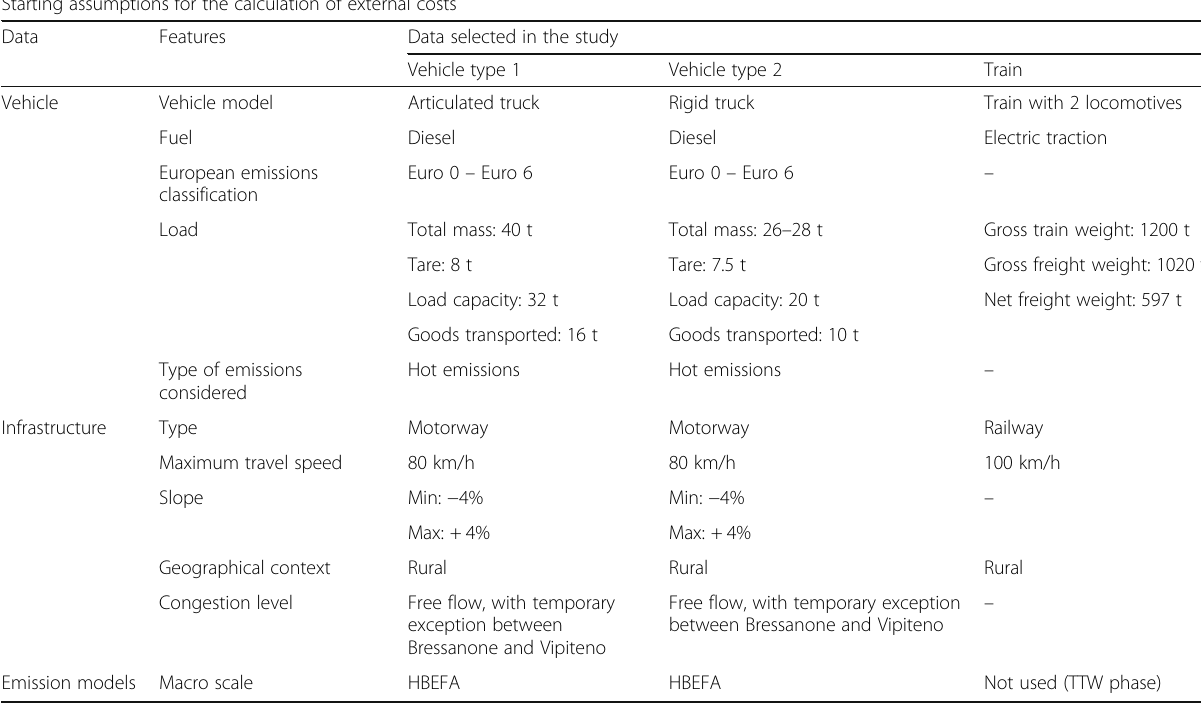
Table 6 Starting data for calculating external costs along the Brenner corridor [35] Starting assumptions for the calculation of external